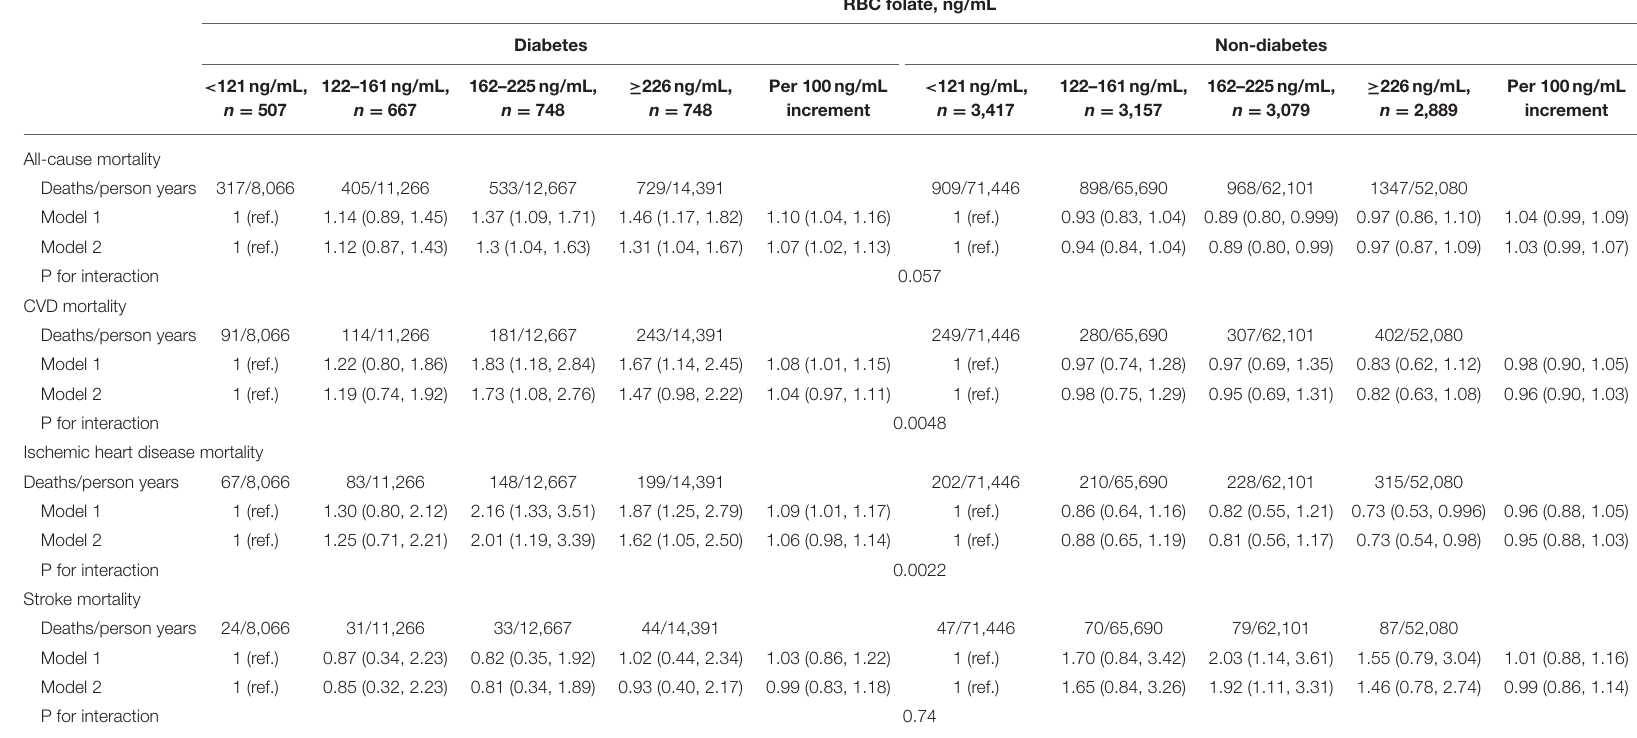
Values are n or hazard ratio (95% confidence interval) and are weighted except No. of deaths/ person years. Model 1: adjusted for age, sex and race/ethnicity, education, family income level, smoking status, alcohol intake, physical activity, TEI and HEI-2010. Model 2: model1 + BMI, history of hypertension, history of dyslipidemia, baseline CVD and baseline cancer, diabetes medication use. P for interaction is only for model 2. TEI, total energy intake; HEI, Healthy Eating Index; BMI, body mass index; CVD, cardiovascular